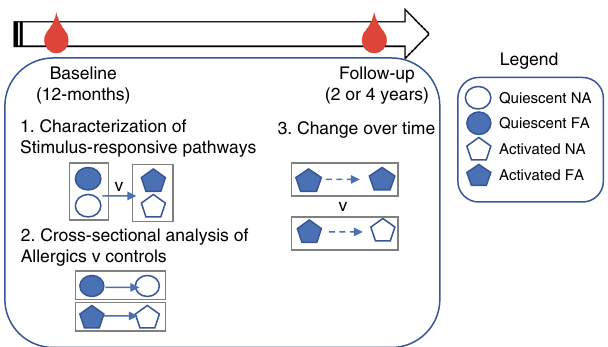
Fig. 1 Overview of study design and analysis. Clinical assessments occurred at baseline and the allergic subjects were re-assessed several years later at follow-up, at which point 59% had resolved allergy. Bloods were collected at both time points, and frozen for later analysis. Experiments were batched such that naive CD4 + T cells (baseline and follow-up) were fl ow sorted from bloods prior to cell culture and molecular analyses. NA